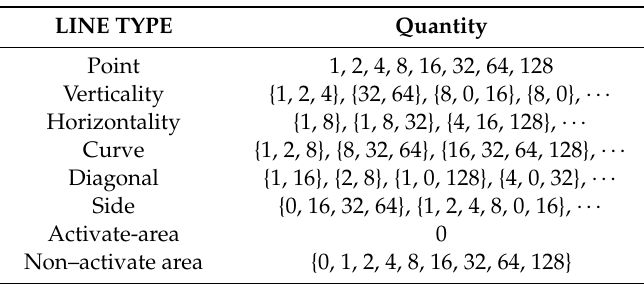
Table 1. Types and values of line segments for the 3 × 3 filter.